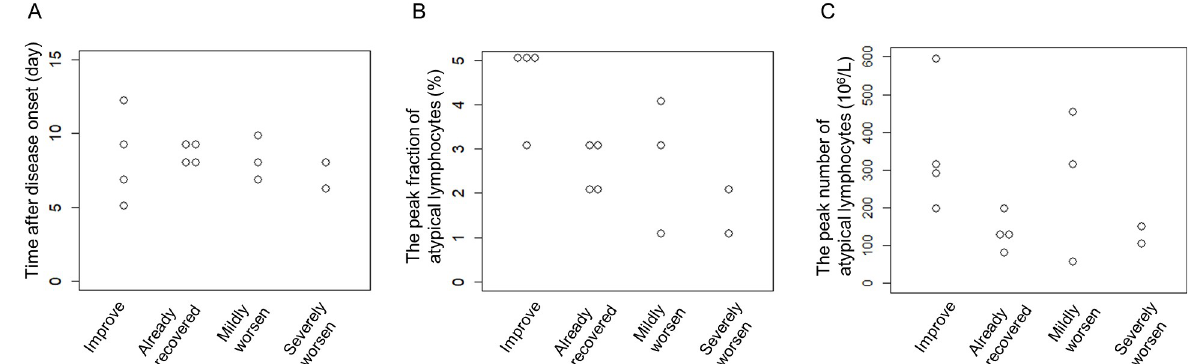
Fig 6. Comparison of clinical indices among clinical courses. (A) Comparison of the date on which atypical lymphocytes appeared. (B) Comparison of the peak fraction of atypical lymphocytes. (C) Comparison of the peak number of atypical lymphocytes. Each plot indicates a patient in a group. No significant differences were detected among groups by one-way